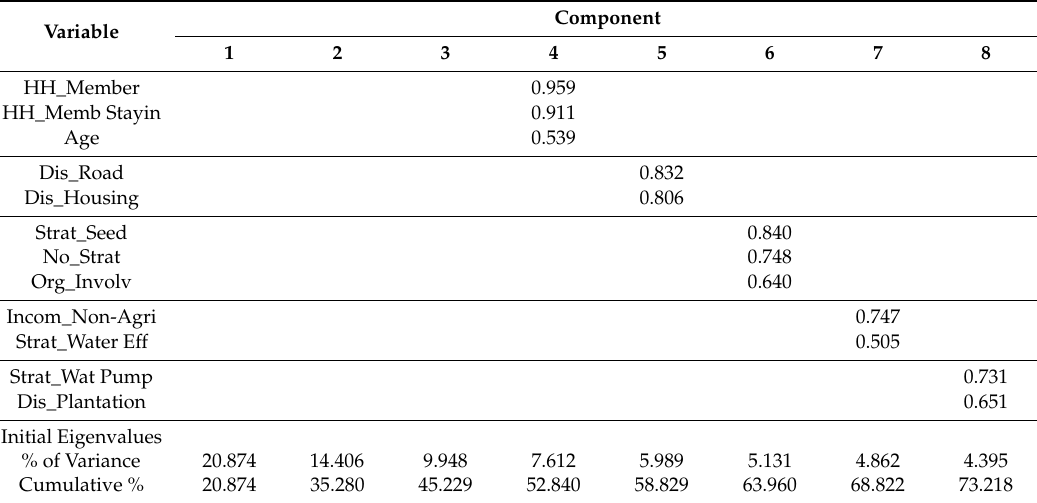
Table 11. Distributed variables for each component as output from the principle component analysis (PCA) pattern matrix.